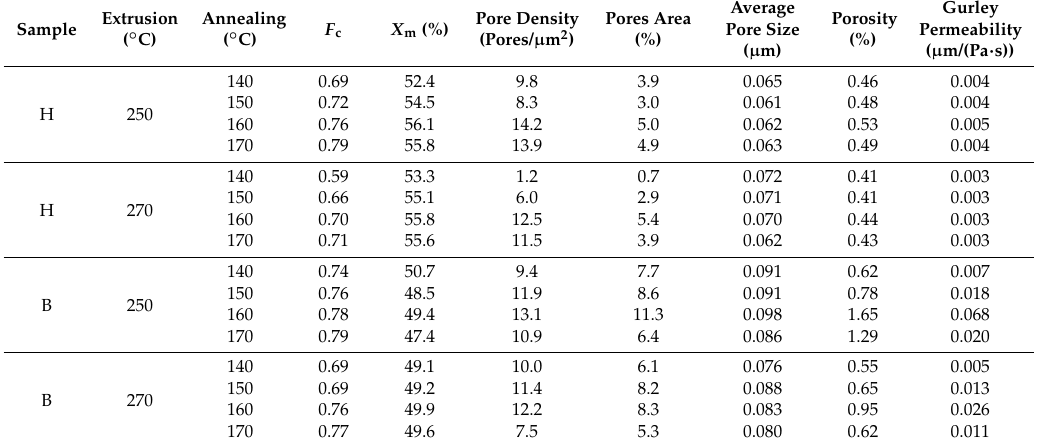
Table 2. Characteristics of neat resins extruded and annealed at different temperatures in terms of orientation of precursor films, and membrane crystallinity, pore morphology, and air permeability. Extrusion Sample ( ◦